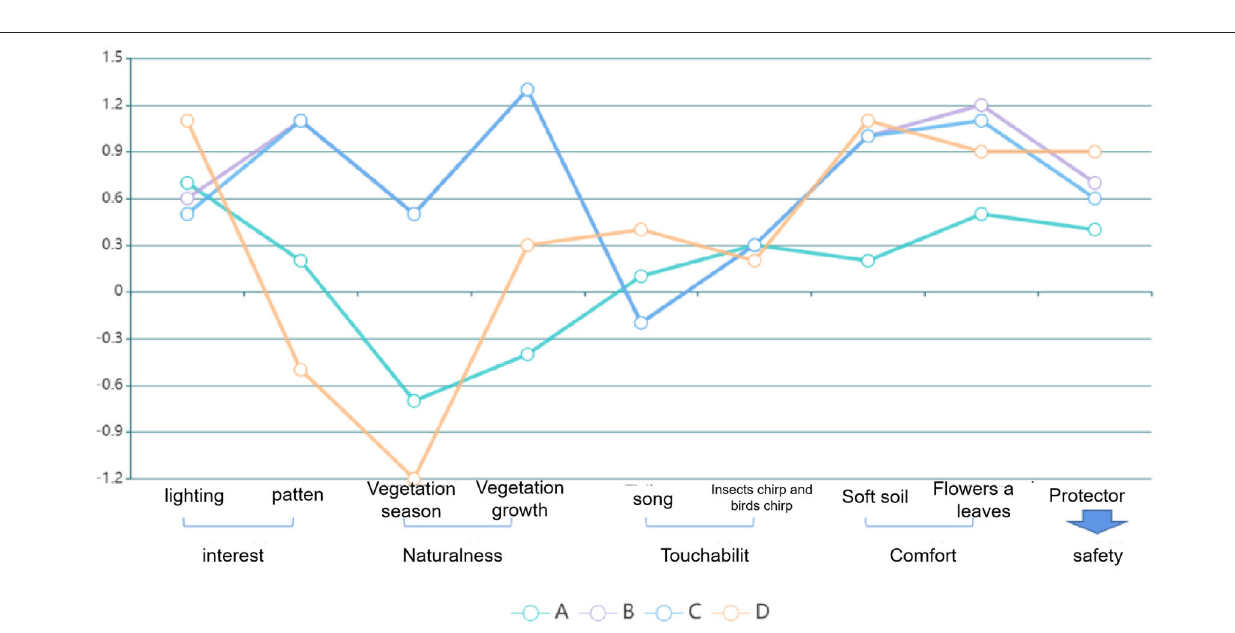
FIGURE 7 | Comparative analysis of PHCSS-SD scores between activity space pattern